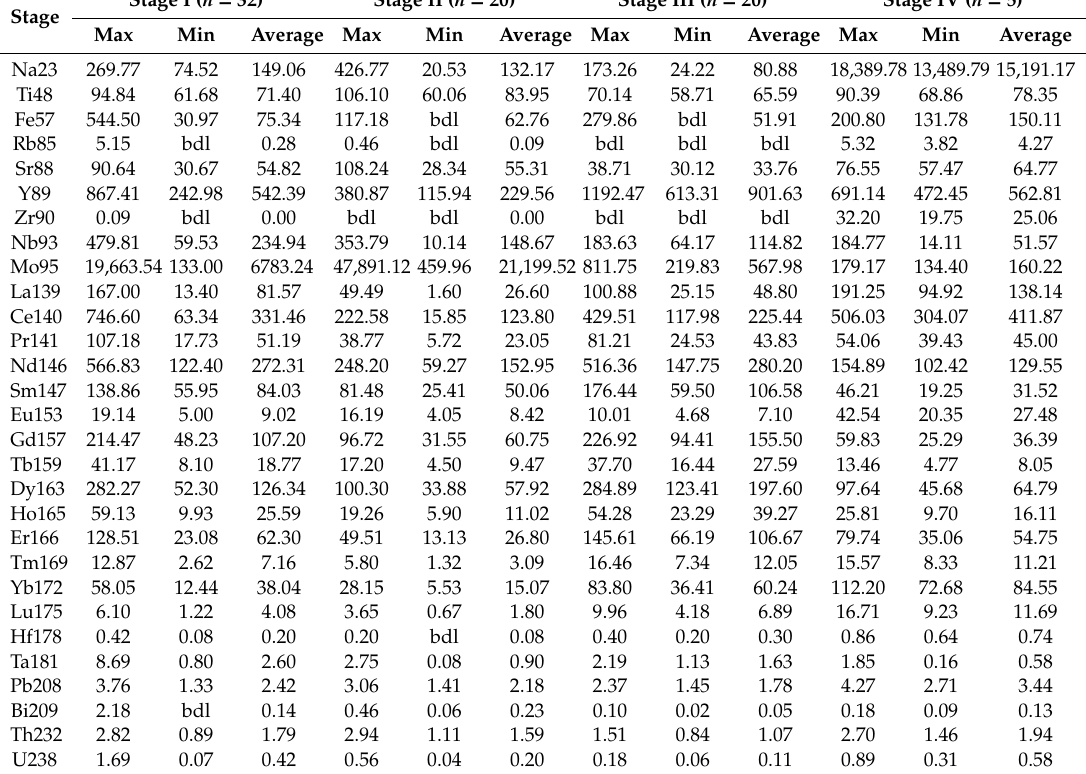
Table 2. Trace element and REE analysis data of Sangdong scheelites (in brief)